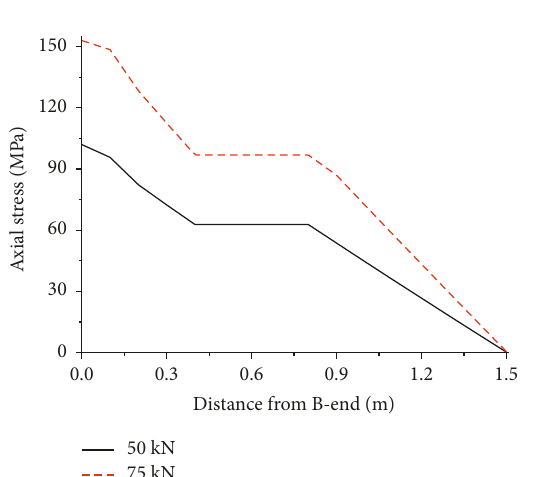
Figure 5: The debonding state under different pullout loads.